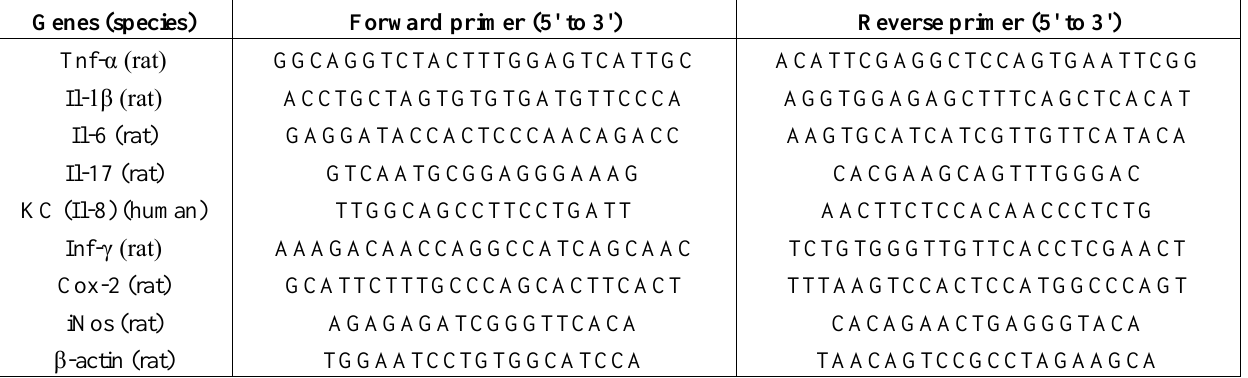
Table A1. Primer sequences used for